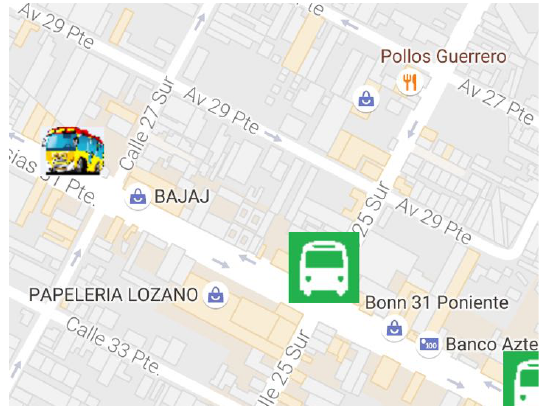
Figure 8. UDLAP Bus First